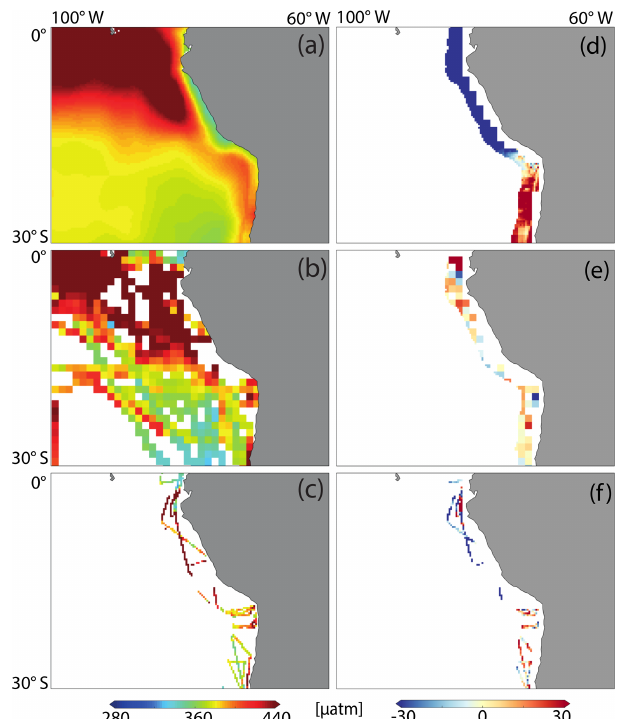
Figure 8. Mismatch analysis along the Peruvian upwelling region for the 1998 through 2015 period. The climatological mean p CO 2 is reported for (a) the merged product, (b) all available SOCATv5 data for the open ocean, and (c) all coastal SOCATv5 data (as illustrated in Fig. 1 for the global ocean). The p CO 2 mismatch is illustrated in (d) as the difference between NN coast and NN open . Panel (e) reports the mismatch between the NN open and the SOCATv5 open-ocean dataset along the overlap area, while panel (f) reports the mismatch between the coastal product and the SOCATv5 coastal dataset along the overlap area.